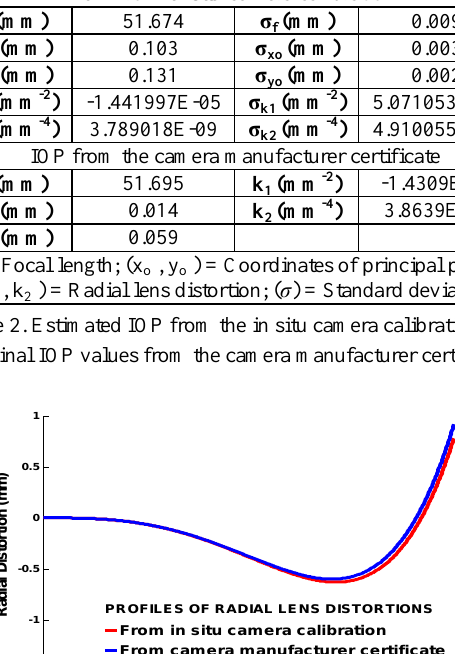
Table 1. Main Results of the Residuals Analysis Performed In Situ Camera Calibration